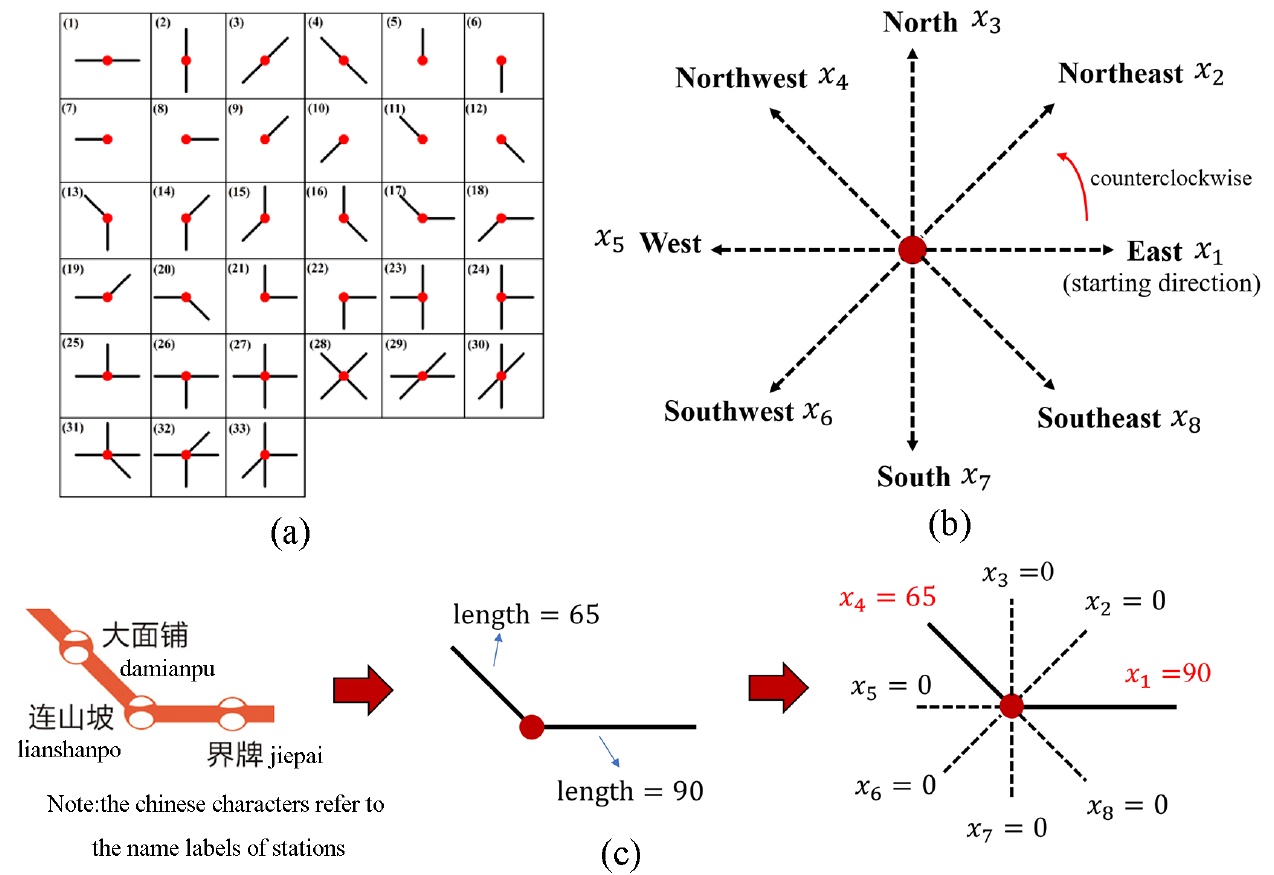
Figure 4. Various station-based line relations between stations and edges: ( a ) some commonly used station-based relations; ( b ) eight variables for coding connections; and ( c ) an example of using eight variables to represent a station-based line relation.